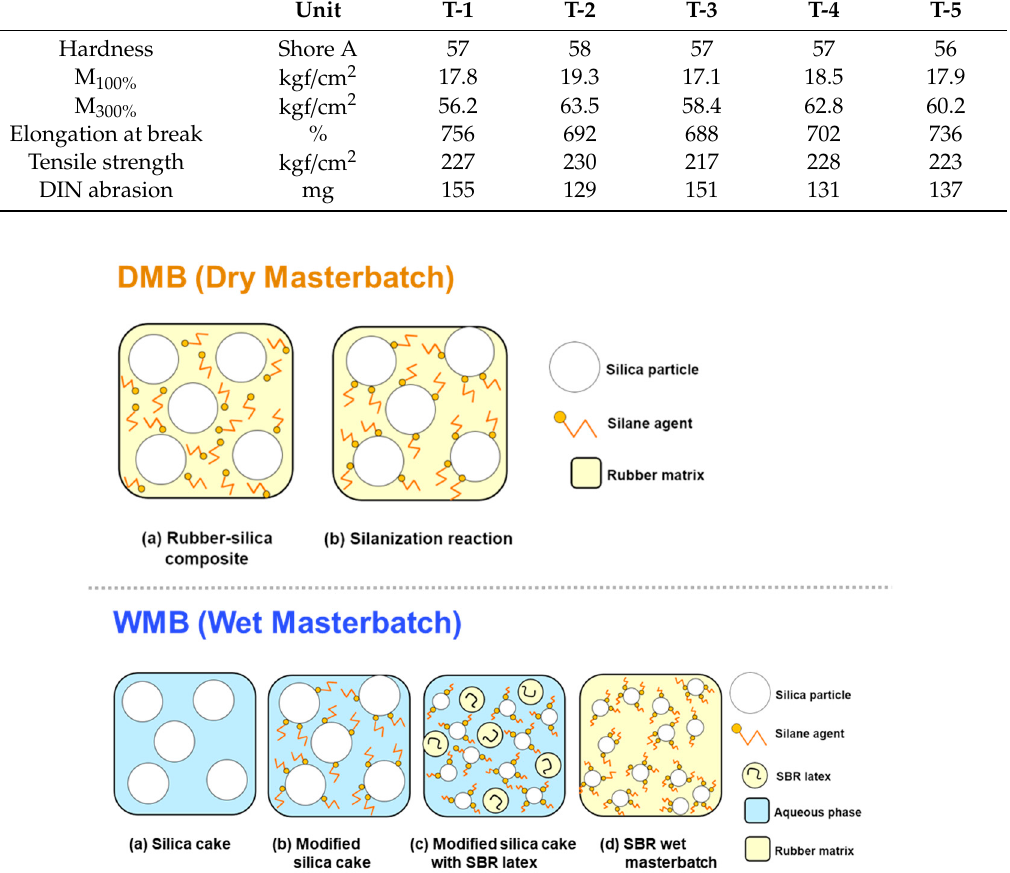
Figure 8. The comparison of the DMB and WMB fabrication processes.